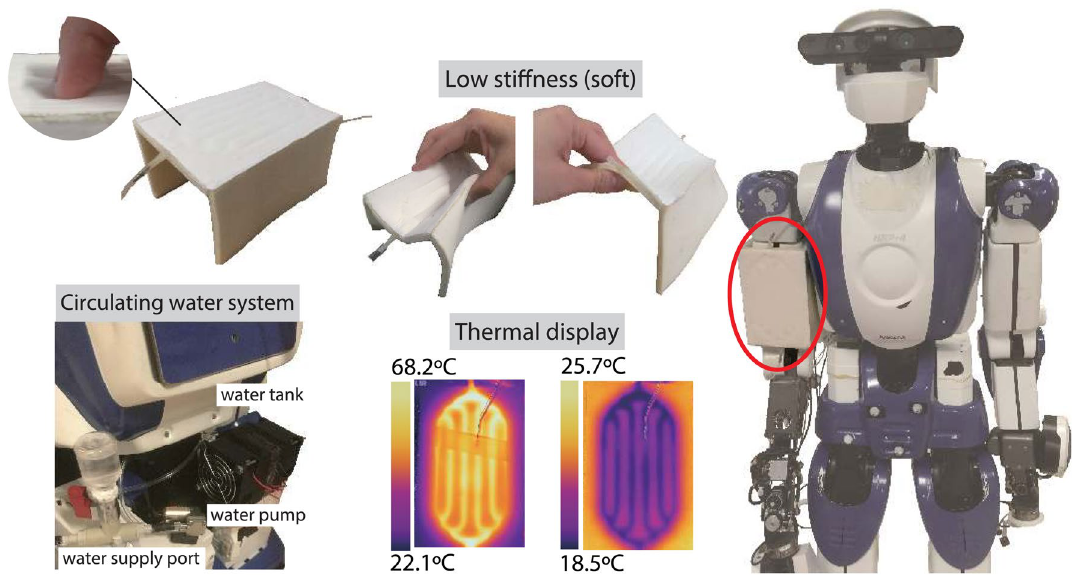
Figure 1. The developed robotic cover. The robotic prototype cover is designed to fit the rigid shell of the humanoid robot HRP-4 right upper arm; it has a ⊔ -shaped to cast the upper arm. Thanks to the materials we used, the cover is deformable that can give a soft tactile impression. The water flow channels are built on the upper arm front side (contactable part by a human). The sides parts of the ⊔ -shaped cover are left without heating for comparison purpose (see later the capacitive sensing part). The circulating water system for controlling the cover temperature was mounted on the HRP-4 backside.